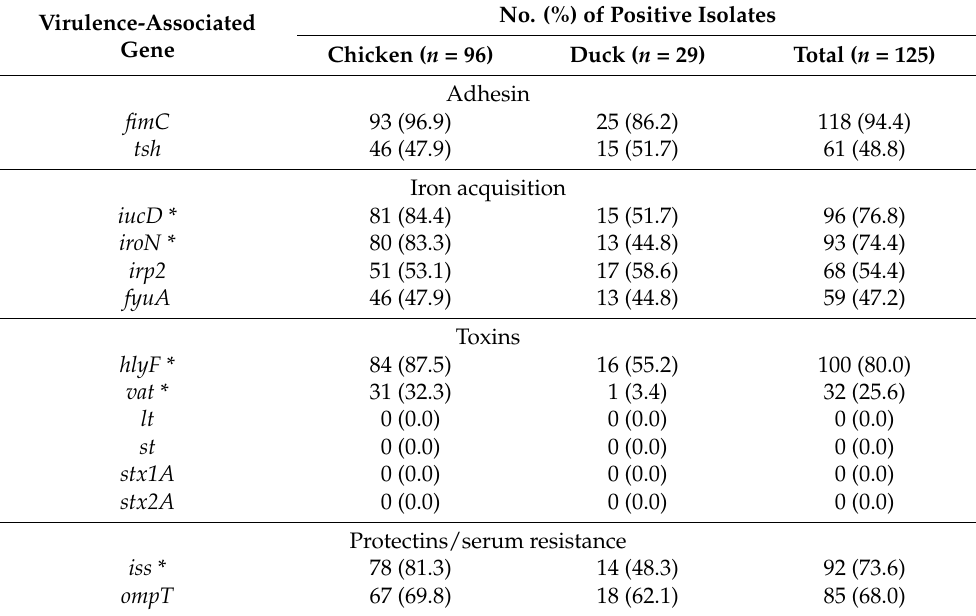
Figure 1. Distribution of phylogenetic groups among 125 APEC isolates. *: significant difference ( p < 0.05) between chicken and duck isolates. Table 2. Frequency of virulence-associated genes in APEC isolates from chickens and ducks.